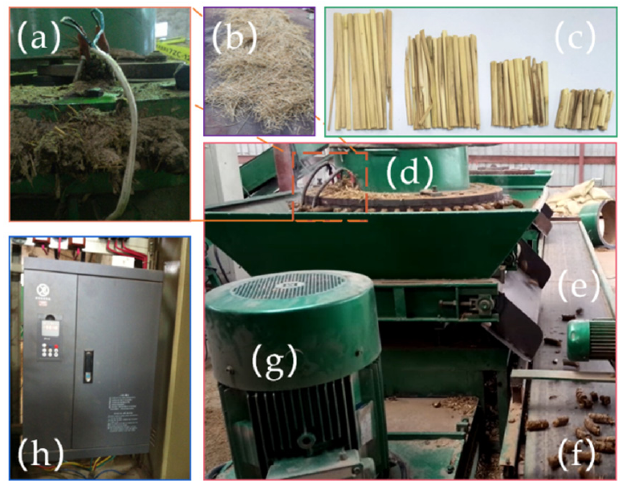
Figure 3. Schematic diagram of the briquetting process: ( a ) Electric heating tubes; ( b ) Dry straw; ( c ) Cut straw; ( d ) Briquetting machine; ( e ) Conveyor belt; ( f ) Briquette; ( g ) Motor; ( h ) Variable-frequency drive.